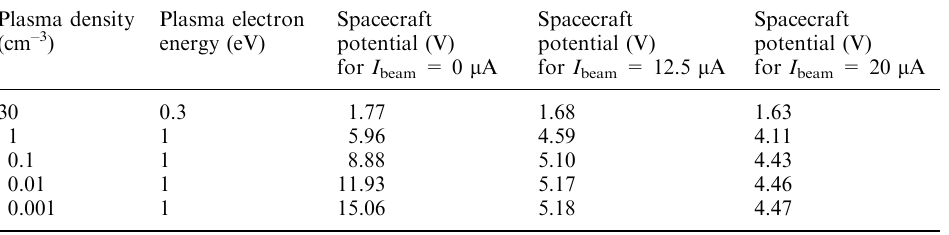
Table 1. Spacecraft potential calculated for di(cid:128)erent ambient plasma